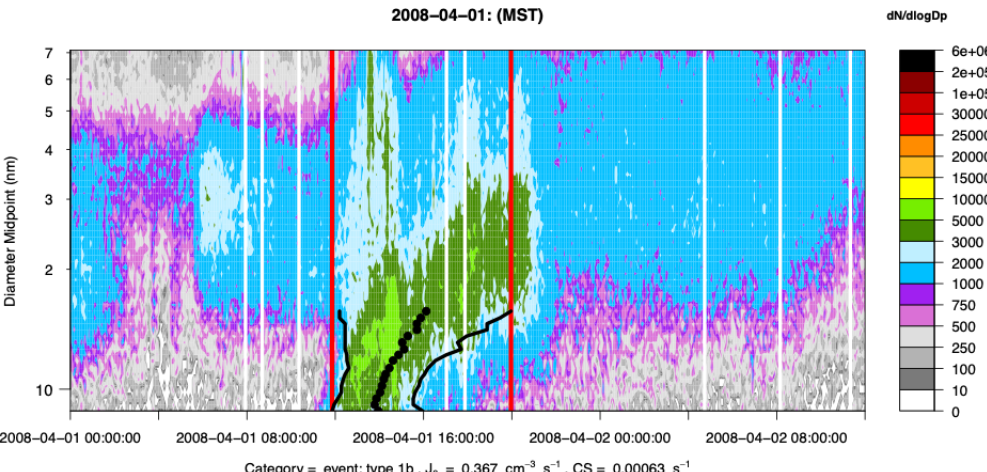
Figure 2. An example of a day classified as a type 1b event. Setting 15nm as the diameter that the growth Gaussian maxima must reach allows for this day to be classified as an event demonstrating why the threshold is set at 15nm. Gaussian maxima (black points) are outlined by the first-order derivative of the fitted distribution at each size (black line). The vertical red lines denote the initiation and end times of a given event as assigned by the automated